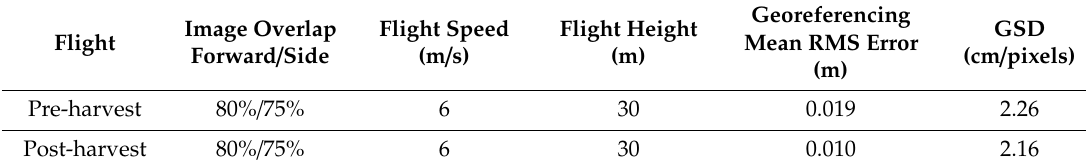
Table 1. Details of UAV image acquisition and orthomosaic quality summary.